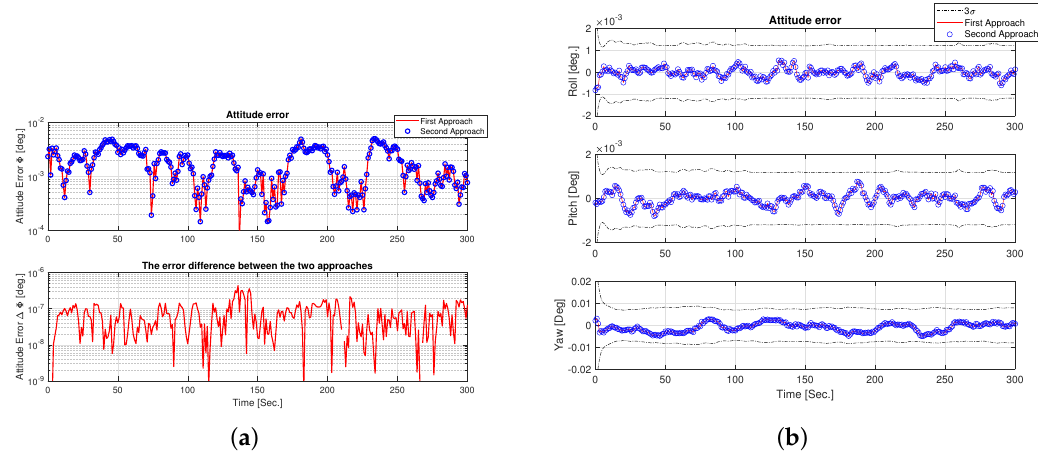
Figure 4. Attitude estimation. ( a ) Attitude estimation error: principal angle. ( b )Attitude estimation error: Euler’s